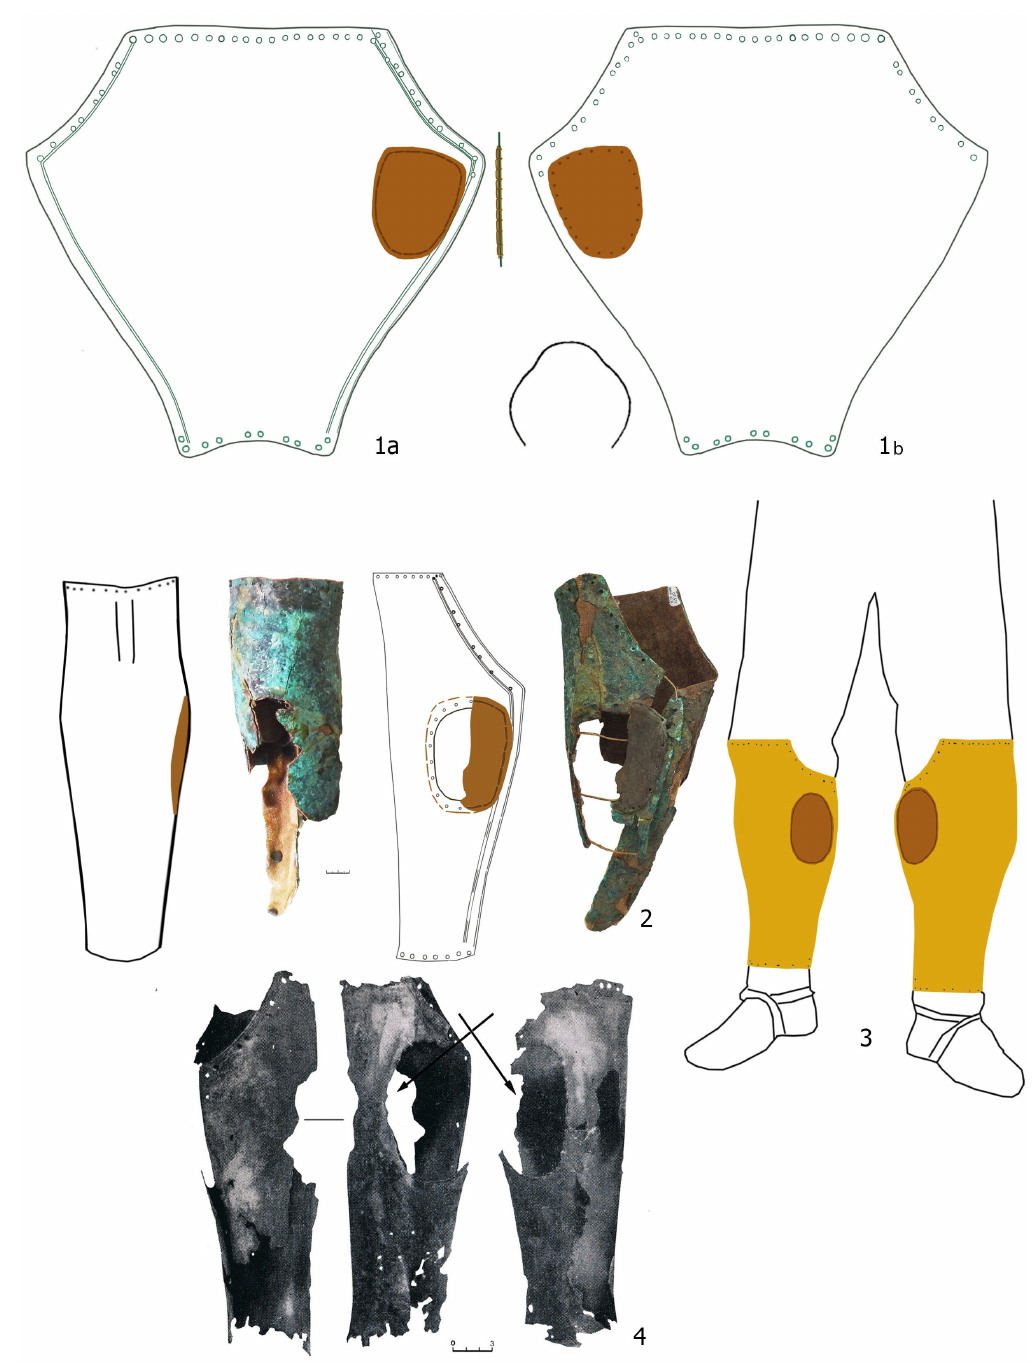
Figure 11. Vodoslavka Barrow 6 Burials 1–2. (1)—“Pattern” of the Vodoslavka’s greaves